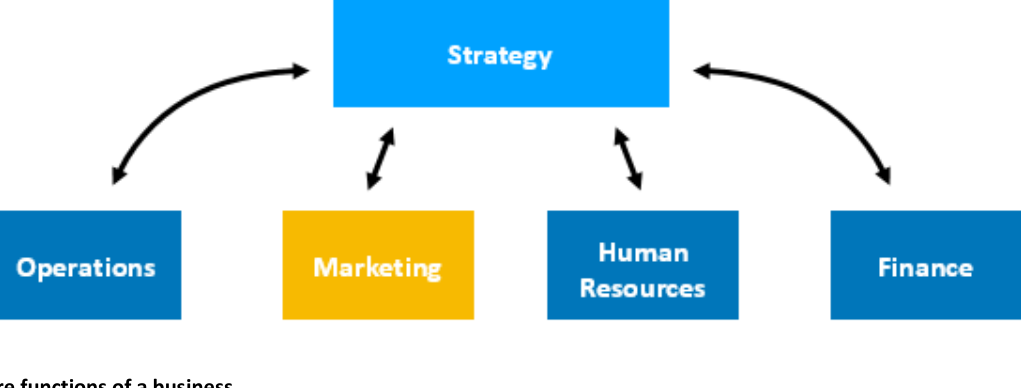
Figure 6. Core functions of a